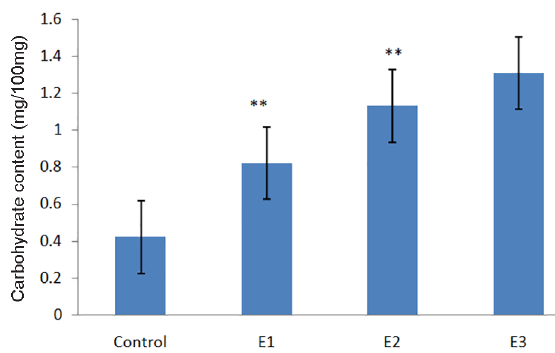
Figure 4. Change in Carbohydrate content in the experimental plants